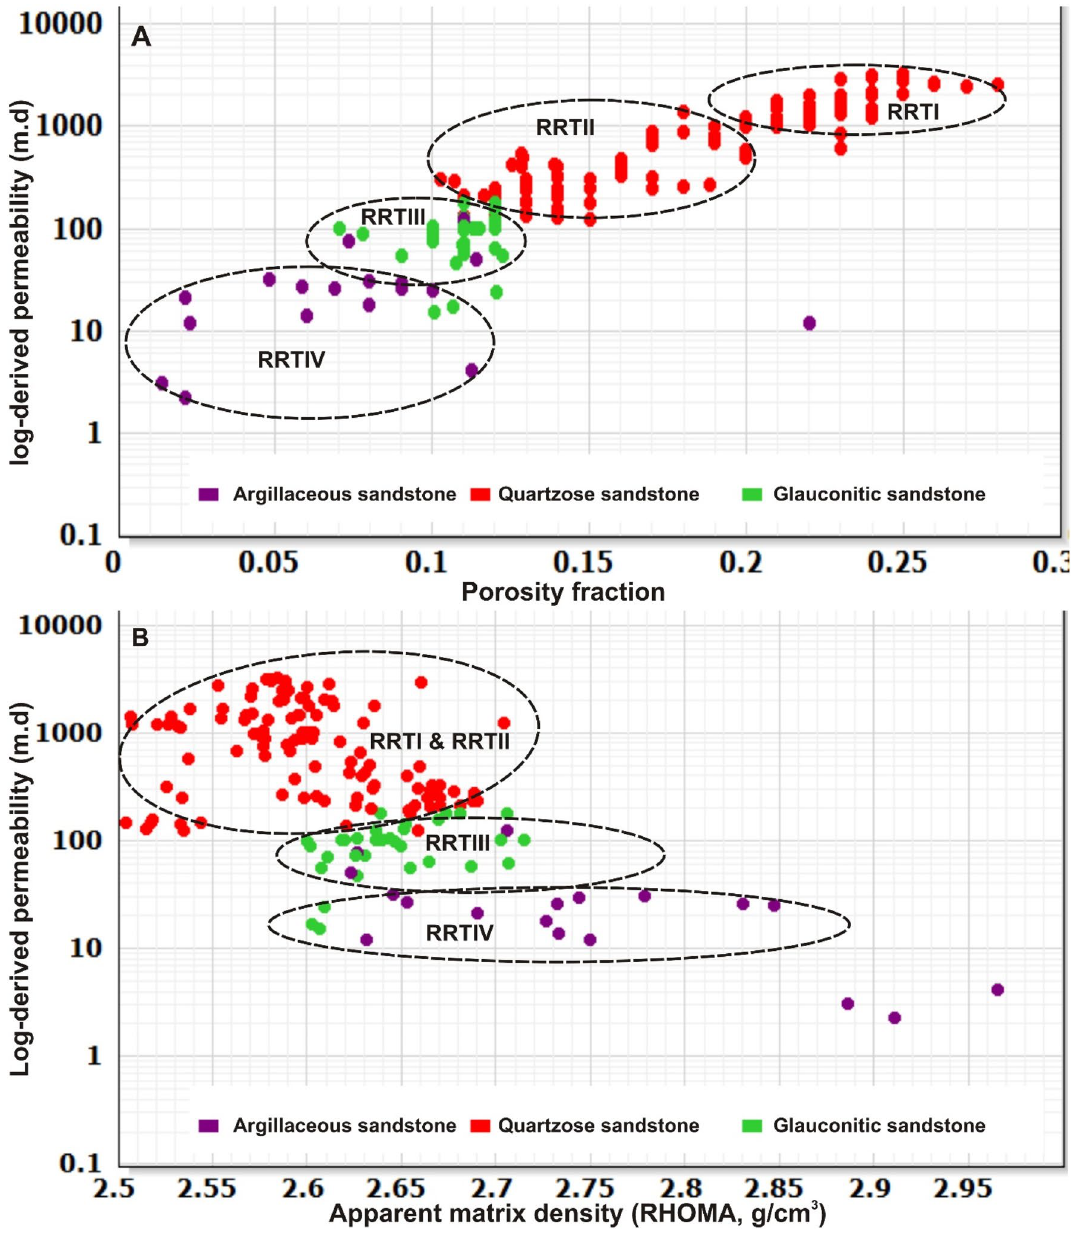
Fig. 13 Cross-plots of wireline log-derived petrophysical parameters illustrate four different RRT in the Abu Madi fluvial unit similar to the results retrieved from core analyses